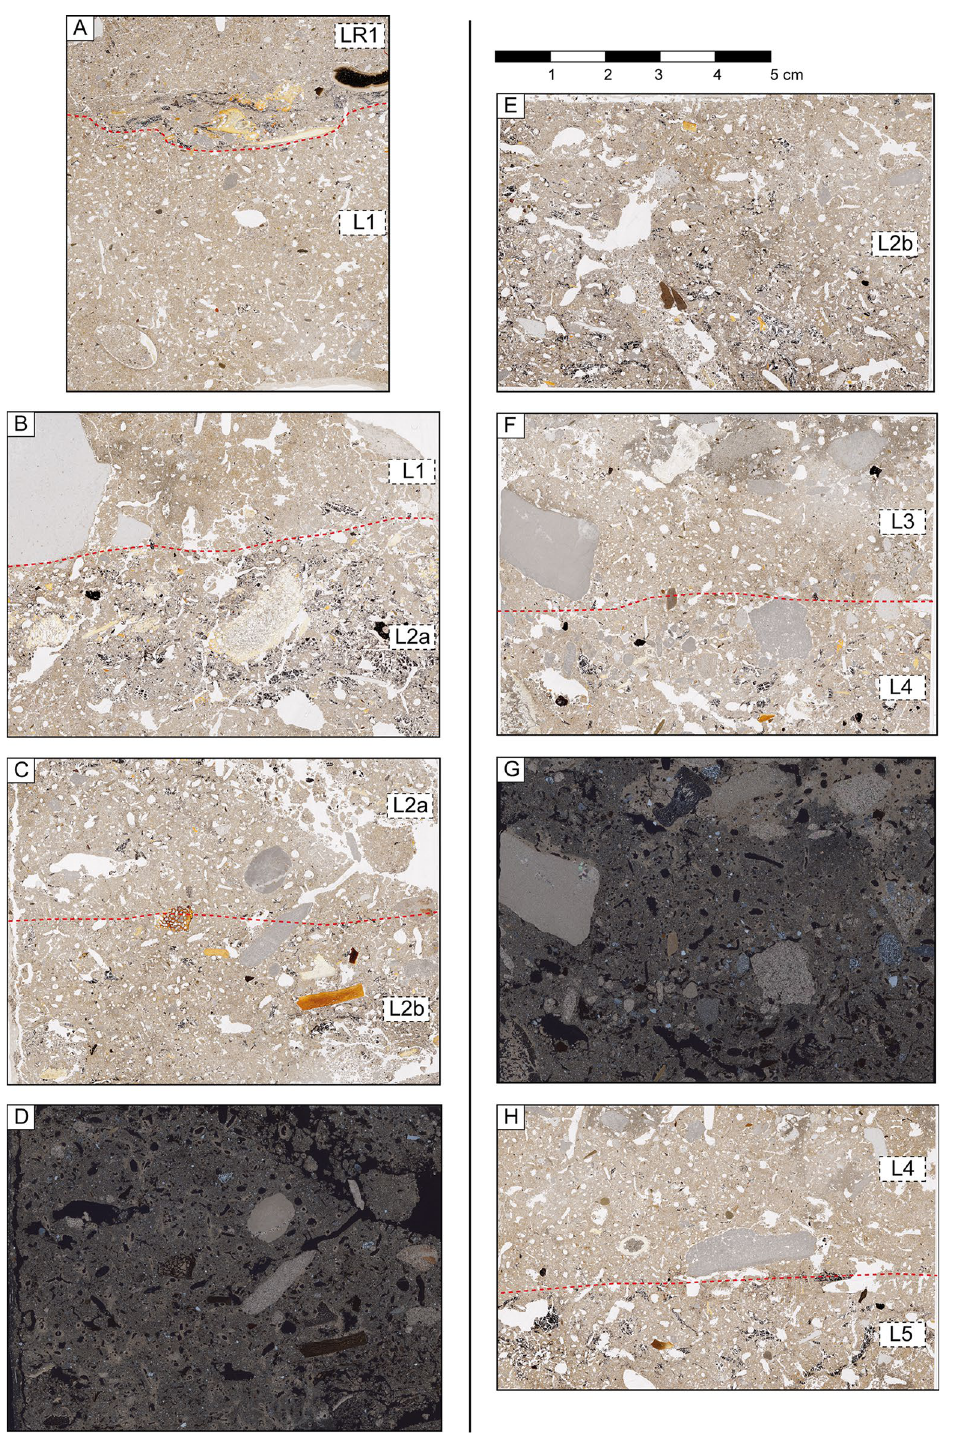
Figure 5. Flatbed scans (1200 dpi) of selected thin sections from the sediment sequence at Peña Capón. ( A ) Erosional contact between level R1 (LR1) characterized by strong compaction and a platy microstructure and level 1 (L1) showing less compaction and a channel microstructure. At the interface, a sediment lens rich in charcoal and bone is present (thin section PCPN 1.2). The dashed line is the boundary between the two levels. ( B ) Thin section PCPN 6.1 with the interface between levels L1 and L2a. At the sampling location, the upper part of L2a consists of a 2 cm thick band rich in charcoal and bone fragments. ( C ) Thin section PNCP 3.2 showing the gradual transition between levels 2a and 2b. ( D ) Same as C but captured under XPL. Note abundant calcite hypocoatings around biopores. ( E ) Thin section PNCP 4.1 from level L2b with several large biopores partly refilled with granules. ( F ) The interface between levels L3 and L4, which is delineated by a thin layer of fine gravel. The light-colored L3 shows diffuse impregnation with secondary calcite. ( G ) Same as E, but captured under XPL. Secondary carbonate is indicated by high birefringence. ( H ) Thin section PNCP 3.2 showing the transition from level 4 to level